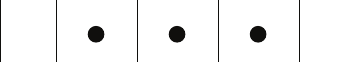
Figure 3: Three-neighborhood structure for one-dimensional CA.